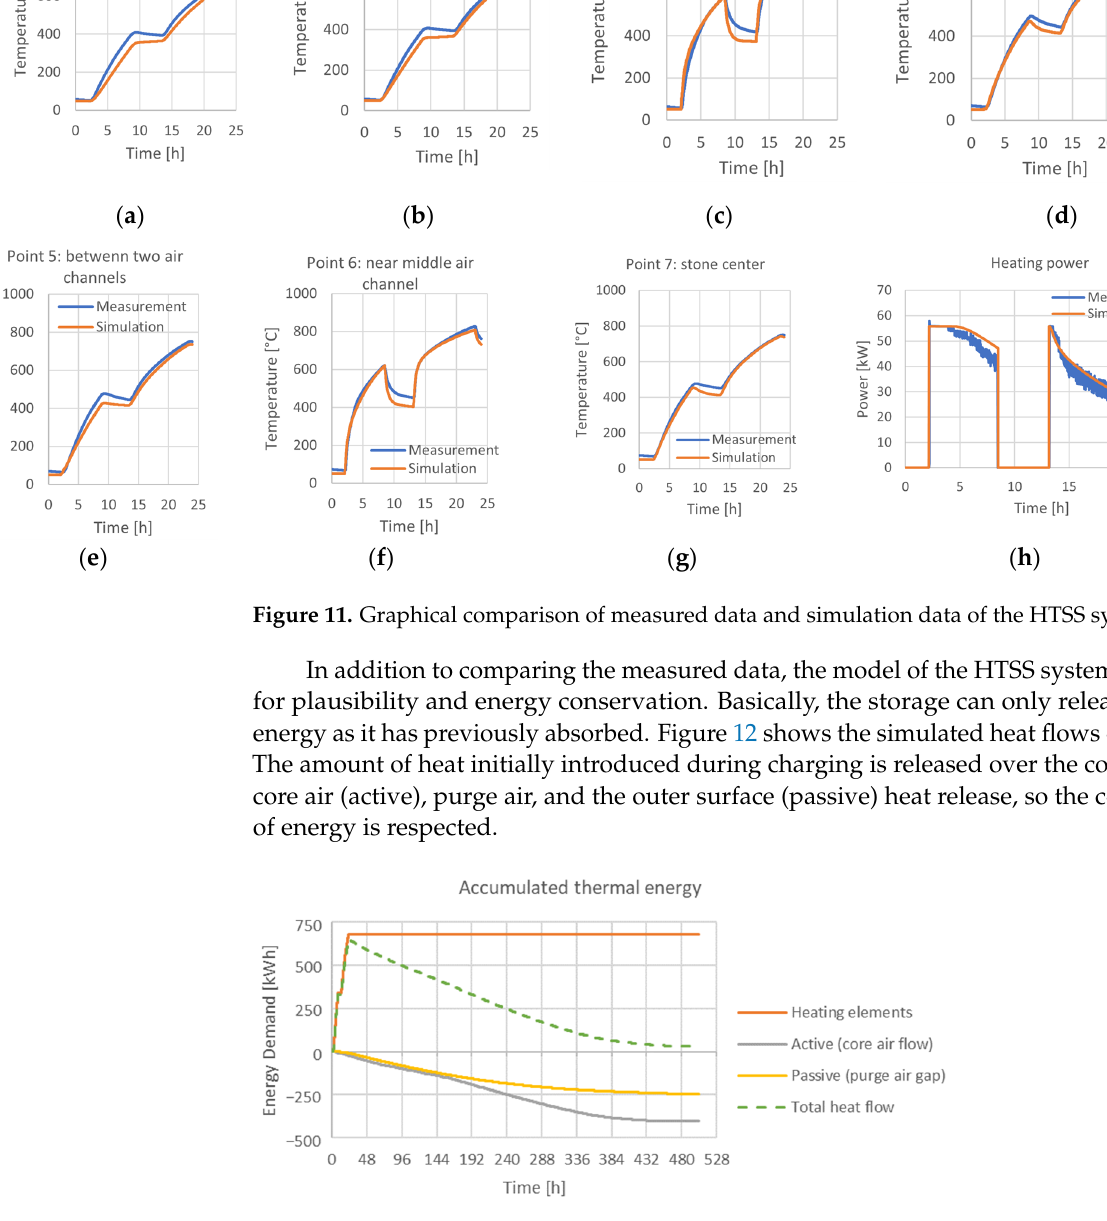
Figure 10. Location of measurement points (highlighted in green) for comparison with simulation variables.